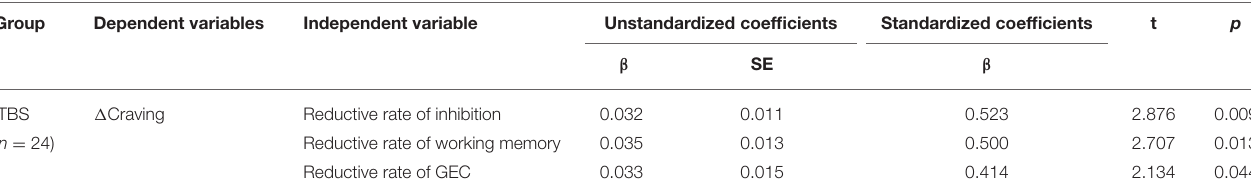
TABLE 5 | Stepwise multivariate regression analysis with changes of craving ( 1 Craving) as dependent variables to explore the effect of the reduction rate of BRIEF-A and drug use history. Group